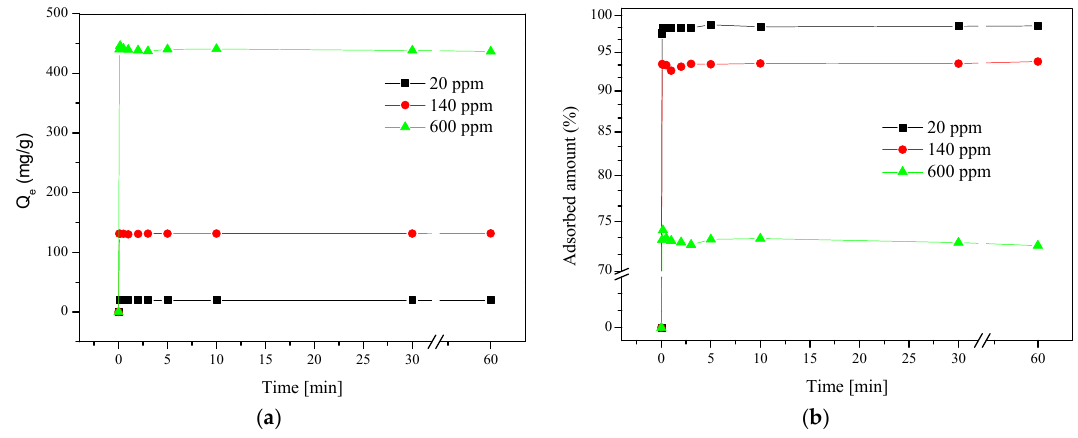
Figure 2. ( a ) PPM of Hg(II) adsorbed to the poly(SDIB)/PMMA fibers versus the time of poly(SDIB)/PMMA fibers in HgCl 2 solution. ( b ) Adsorbed percentage of Hg(II) versus the time of fibers in HgCl 2 solution.